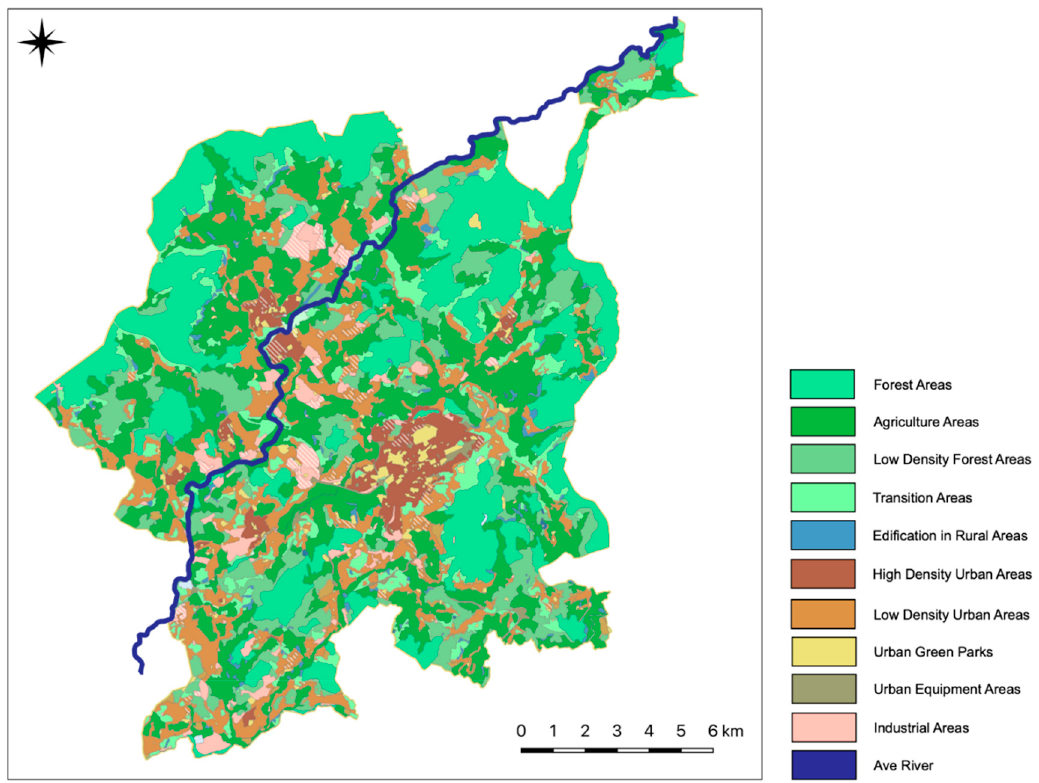
Figure 6. Land Use and Land Cover (LULC) map, highlighting the rural and urban areas of the municipality of Guimarães (adapted from the data collected at https://snig.dgterritorio.gov.pt, accessed on 30 June 2021).